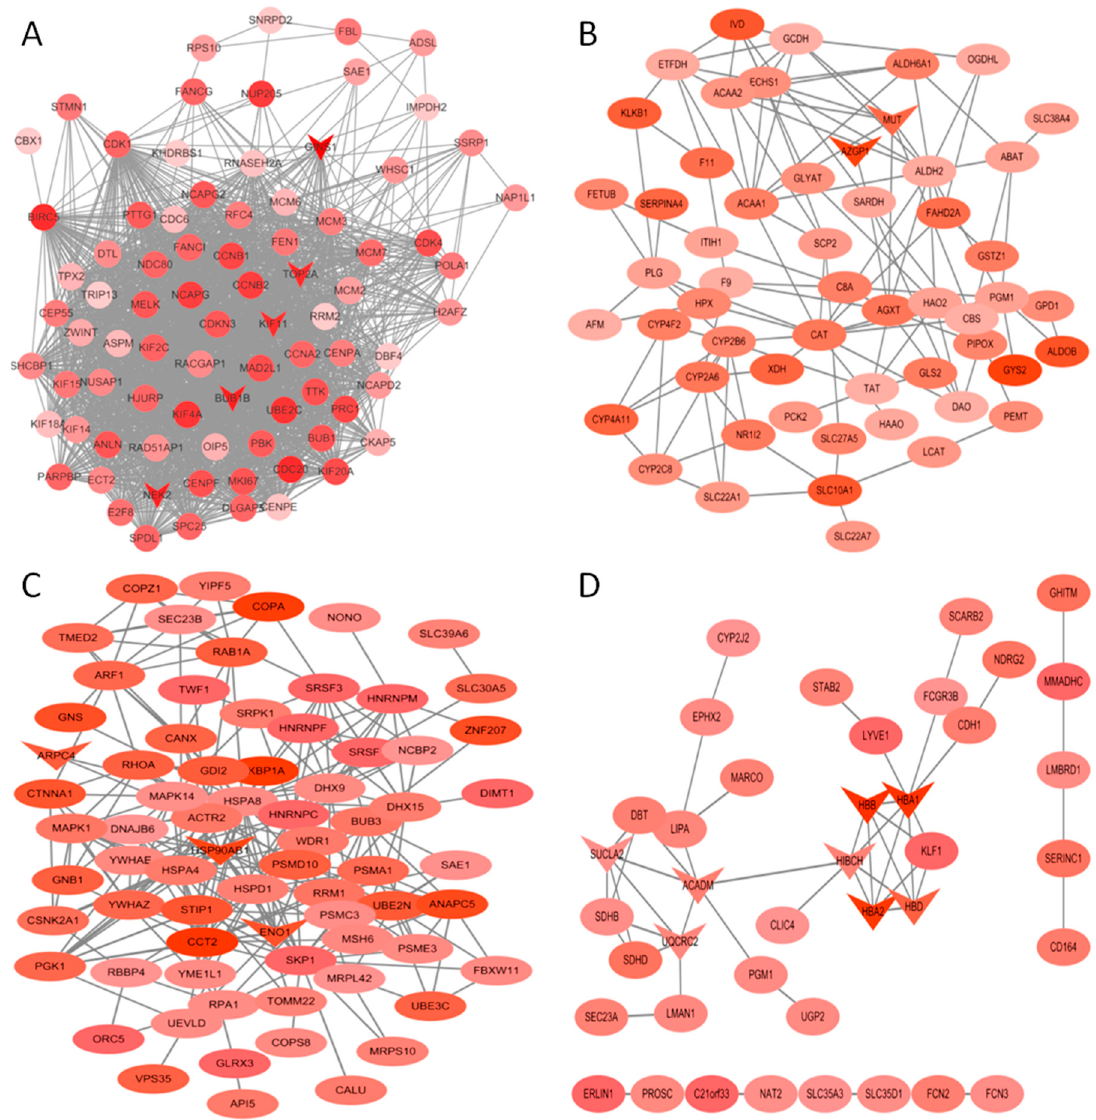
Figure 5. Protein-protein interaction (PPI) network of genes in the turquoise ( A ), yellow ( B ), brown ( C ) and orange ( D ) modules. The density of the ellipse corresponds to module membership (kME) values. The network was constructed using Cytoscape 3.4 software. The genes with a v-shape represent the high-degree genes from cytohubba.